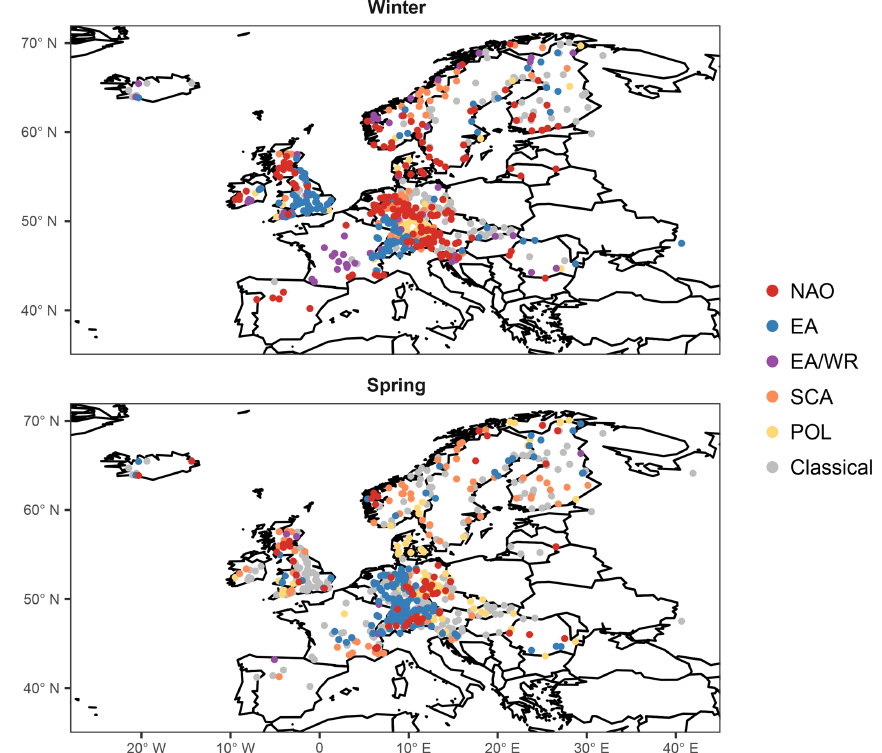
Figure 3. Best overall models among the five climate-informed and classical GEV distribution tested for the winter and spring season. Mean seasonal covariates are